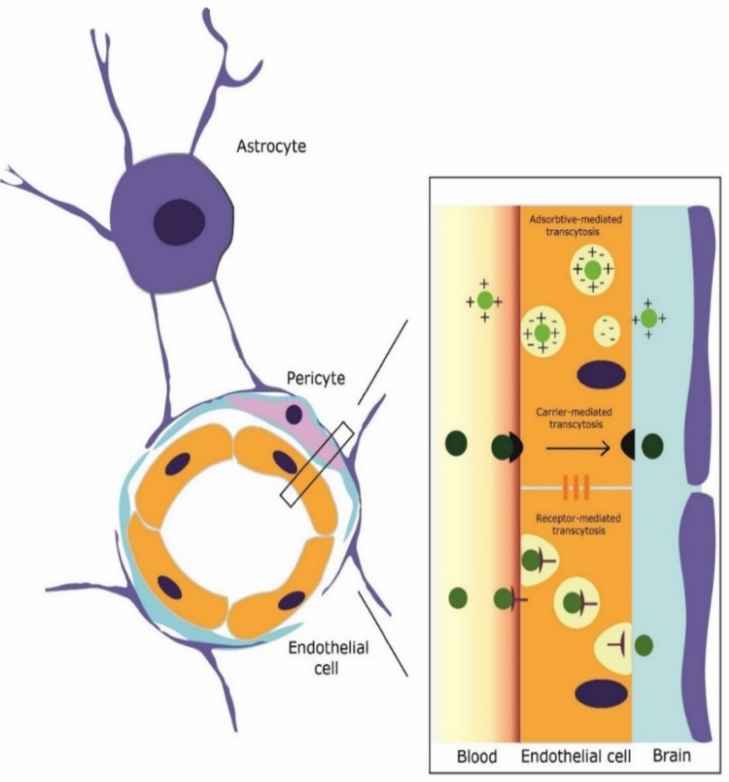
Figure 3. Schematic representation of blood–brain barrier (BBB) structure and possible mechanisms of transcytosis in the case of mesoporous